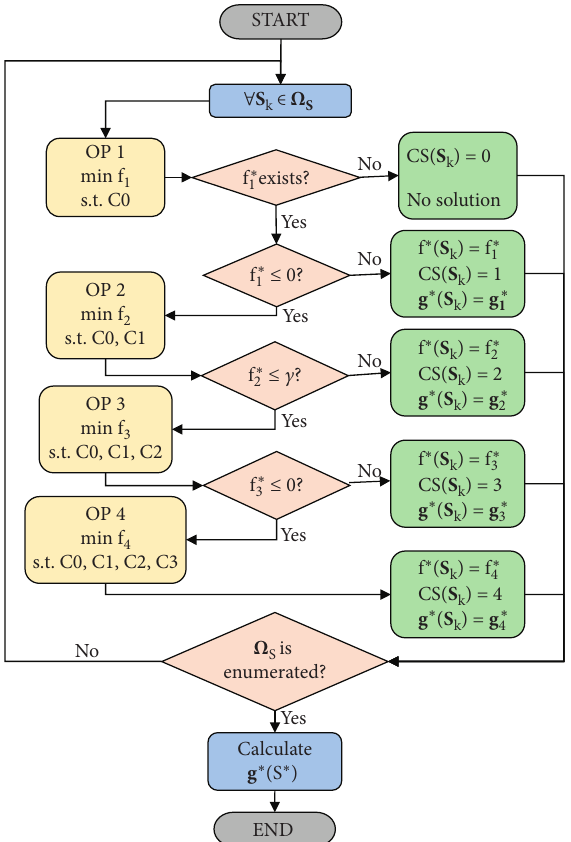
Figure 4: Flowchart of signal control optimization procedure of the SCO